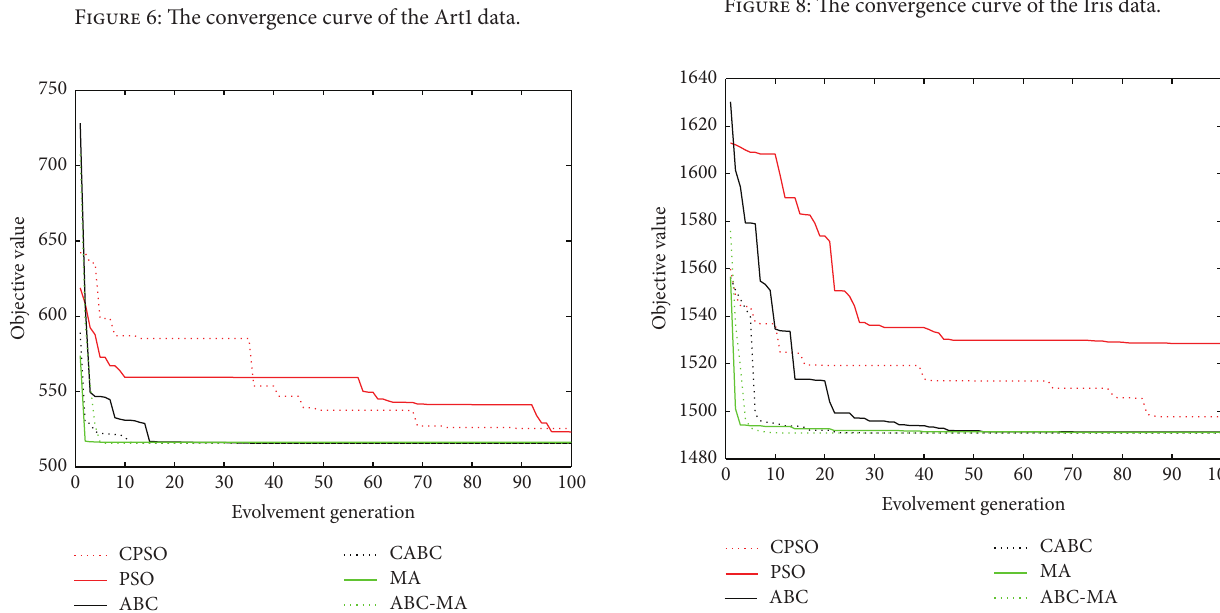
Figure 7: The convergence curve of the Art2 data.